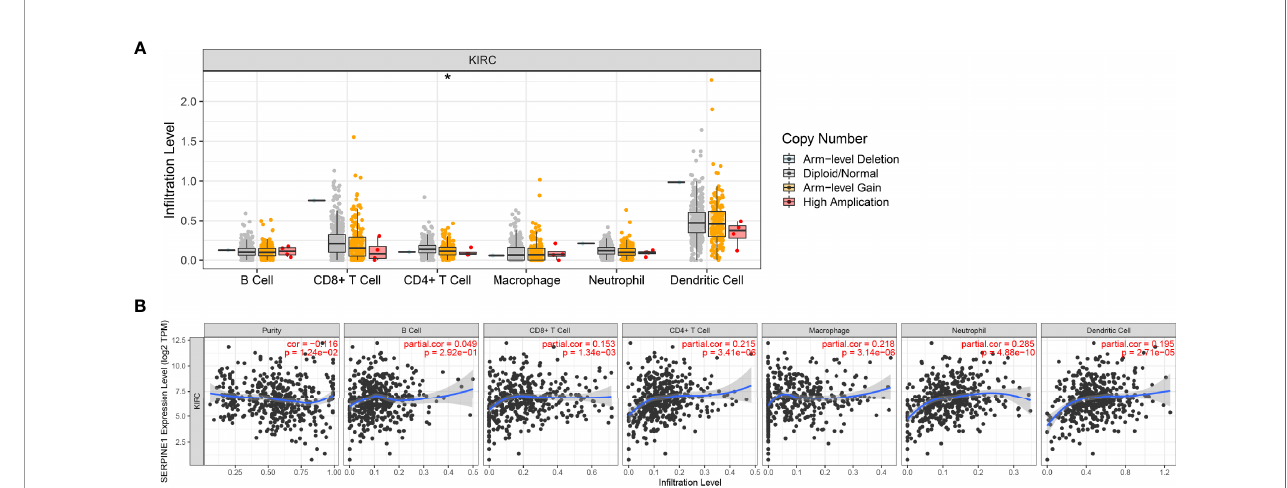
FIGURE 11 | Immune in fi ltration analysis of SERPINE1 in KIRC. (A) Relationship between the level of immune cell in fi ltration and the copy number of SERPINE1 in KIRC. (B) Correlation of SERPINE1 expression and immune cell in fi ltration in KIRC. *p <